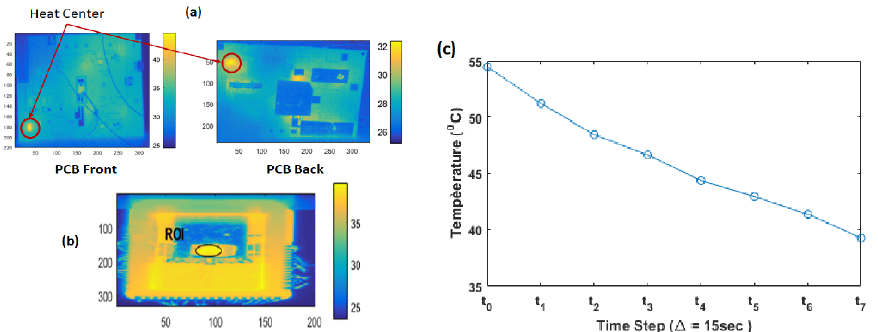
Figure 3. ( a ) color-coded thermal profile of circuit board, front and back, ( b )Region of Interest (ROI), photonic component., ( c ) Obtained Graph of Photonic chip, Distance Camera to target = 8 cm, emissivity= 1 and with time step of 15